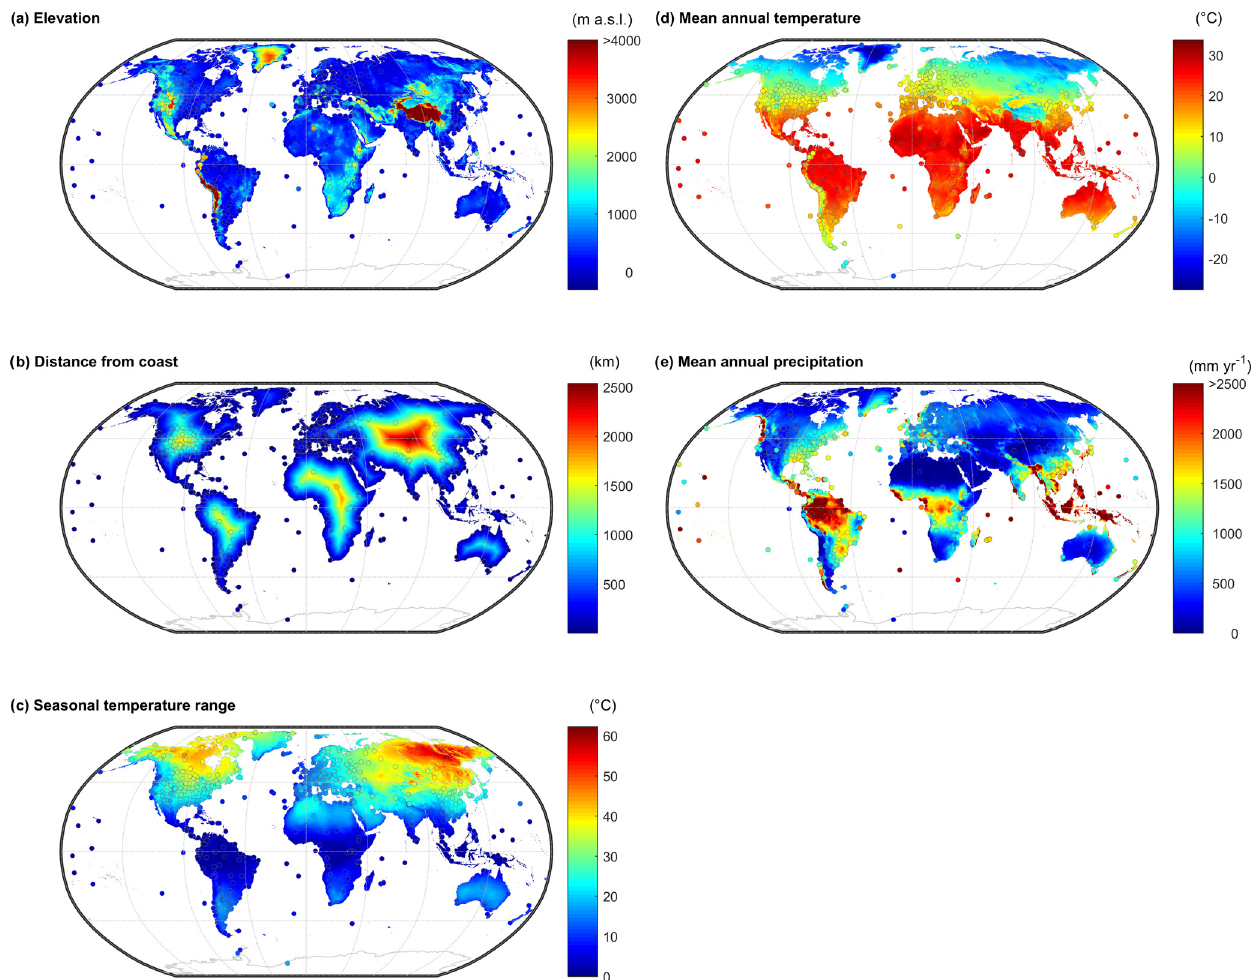
Figure 1. Global maps of site characteristics used for predicting seasonal precipitation isotope cycles: (a) elevation of precipitation isotope monitoring stations plotted over the elevation map, (b) distance from coast, (c) temperature range between mean temperatures of warmest and coldest months, (d) mean annual temperature, and (e) mean annual precipitation. Values at precipitation isotope monitoring stations are marked by circles. For b–e , station-level data are estimated as the value of the grid cells that the stations